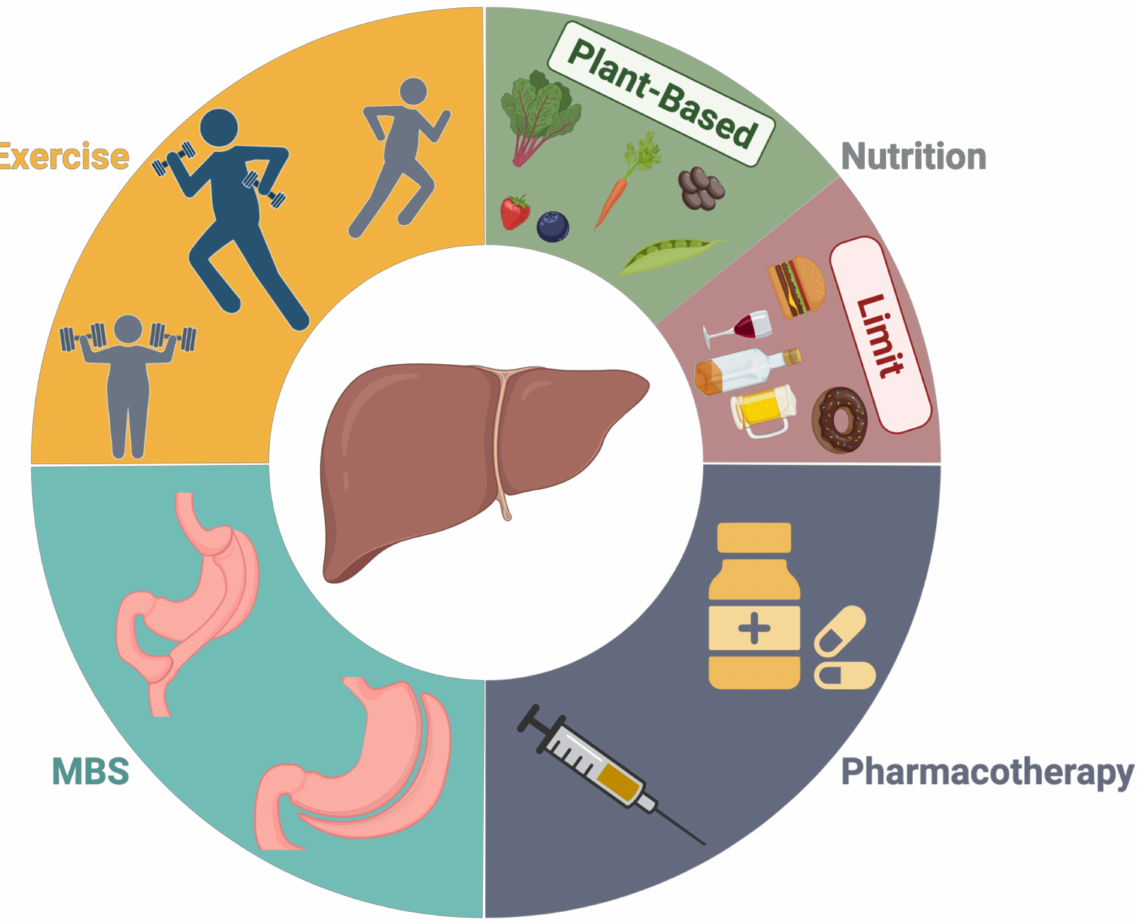
Figure 2. A combination approach for effective-sustained weight reduction is recommended for preventing obesity-related hepatocellular carcinoma (HCC). A combination of lifestyle, surgical, and/or pharmacotherapy interventions allows for the development of a person-centered adaptive approach to weight reduction and weight maintenance. Both aerobic and resistance exercise have been found to reverse the severity of MAFLD, albeit via different mechanisms. Thus, a combination of aerobic and resistance exercise is recommended for improved liver health, maintenance of lean body mass, and 5% weight reduction. Evolving expert panel consensus has determined that dietary patterns that support increased plant-based consumption and limit energy-dense, nutrient-poor foods and alcohol decrease the risk of HCC. For people who have MAFLD, a 20–30% calorie restriction is recommended to achieve 5–10% weight reduction, with specific limitations of saturated and trans fats and simple sugars. BMS can induce upwards of 25–50% sustained weight reduction and has been shown to reverse the severity of MAFLD and reduce the risk of HCC. Weight-reducing pharmacotherapies hold great potential for the treatment of MAFLD and have been shown to reduce the risk of